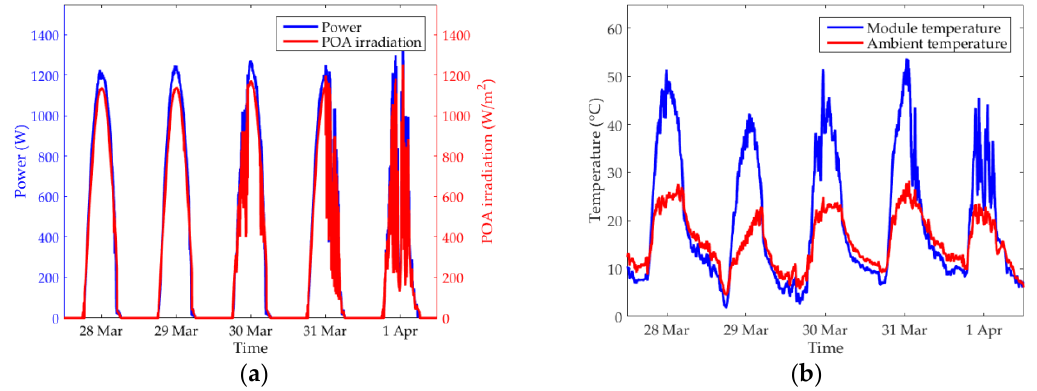
Figure 1. Measurements of meteorological data and PV output from 28 March to 1 April 2015: ( a ) power output and plane-of-array (POA) irradiation; ( b ) ambient and module temperature.